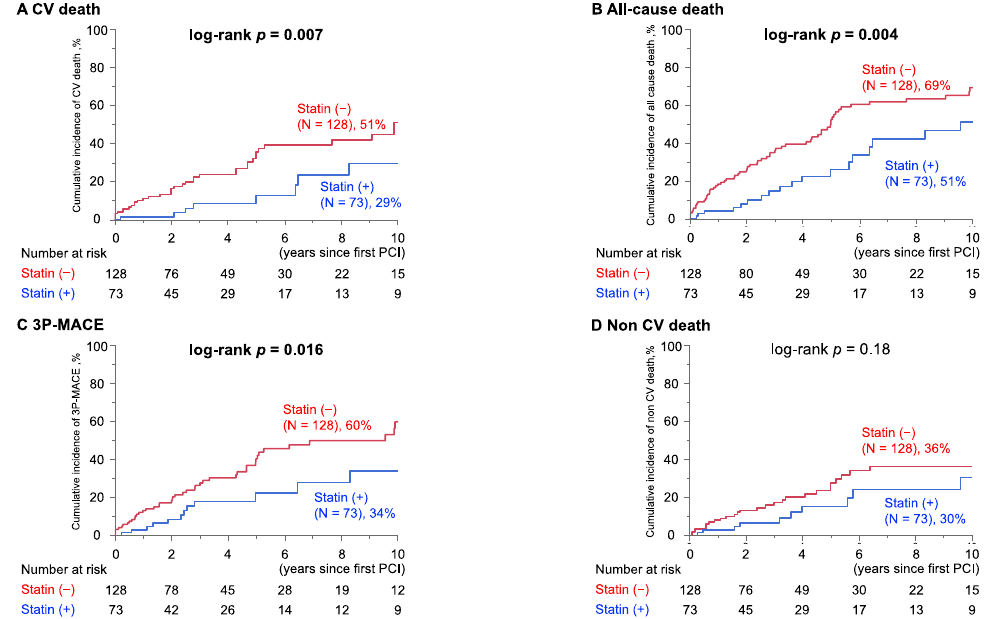
Figure 1. Cumulative cardiovascular event rates in groups with and without statins. Significantly reduced cumulative incidences of ( A ) CV death, ( B ) All-cause death, and ( C ) 3P-MACE were observed in patients with statin therapy at PCI, while no difference in ( D ) Non CV death was seen. Percent indicates the cumulative incidence of events at 10 years of follow-up in each group.